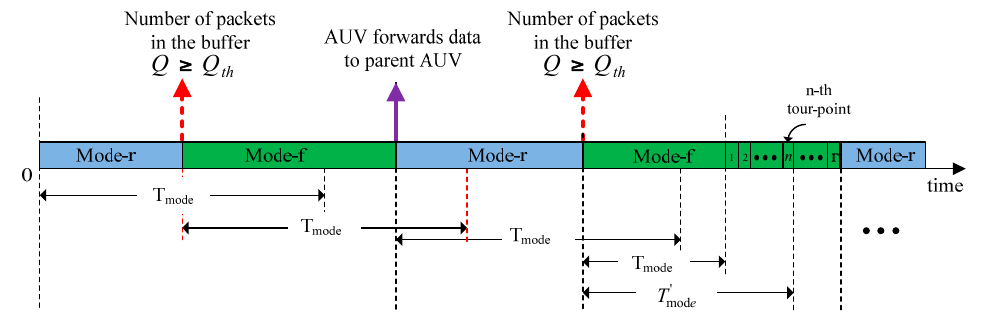
Figure 6. AUV operating mode transition diagram.